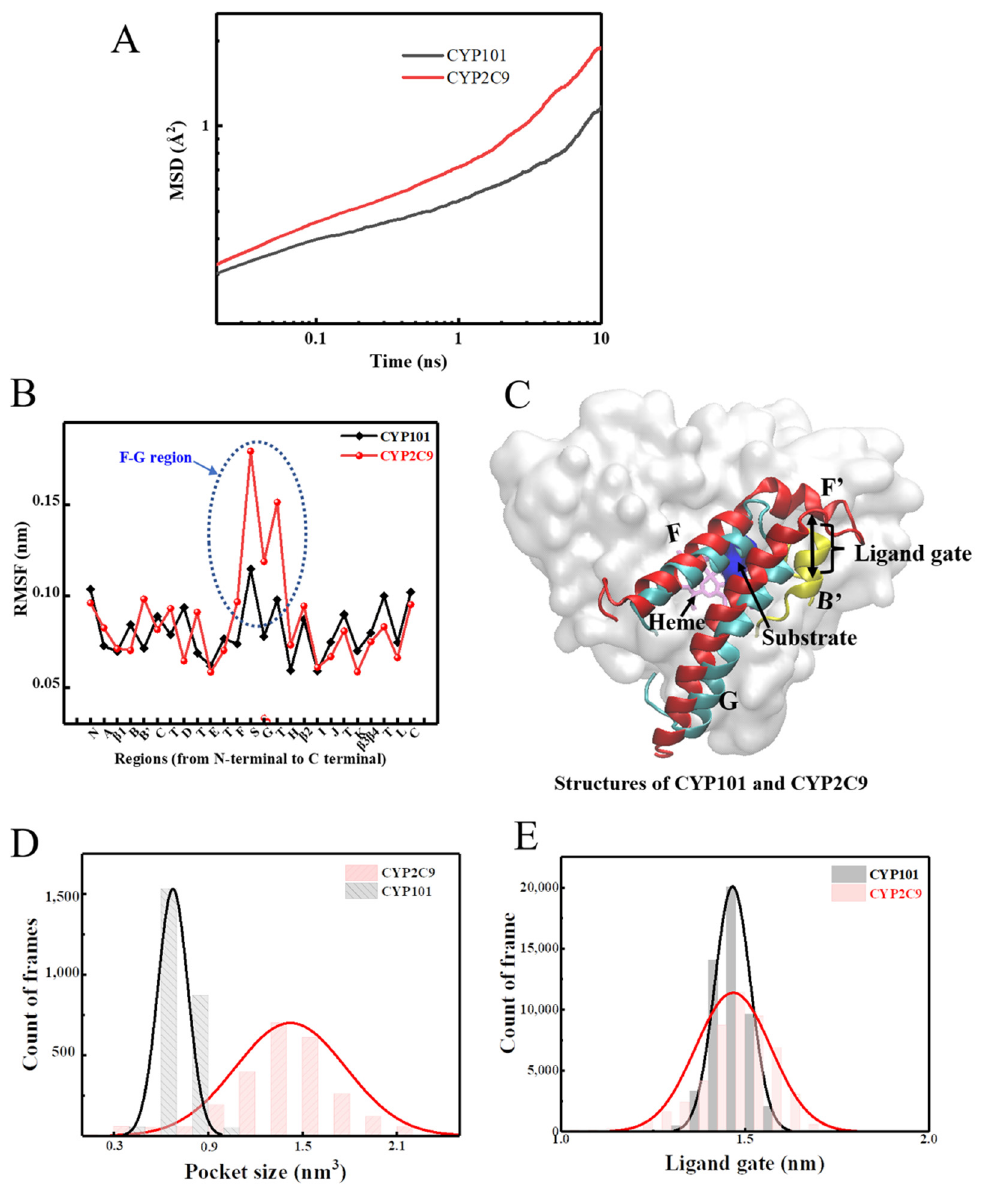
Figure 3. MD-derived flexibilities in CYP101 and CYP2C9 obtained by analyzing three independent 500 ns simulations for each protein. ( A ) Global flexibilities indicated by mean-squared atomic displacement (MSD) (10 ps to 10 ns). ( B ) Local flexibilities suggested by root-mean-square fluctuation (RMSF) clustered on the secondary structures, where the blue dotted circle highlights the most evident difference, appearing at the F–G region. We note that the symbol “S” marked in red corresponds to a linker connecting F and G helices. This linker is composed by coils and F’ helix in CYP2C9 but only a short coil in CYP101 (see Figure 3C). ( C ) Superposition of the crystal structures of CYP101 (cyan, PDB 1DZ9) and CYP2C9 (red, PDB 5XXI) with the F–G region and B’ helix (yellow) highlighted. The ligand gate controlling the opening and closing of the ligand access channel is formed by the B’ helix and the linker connecting F and G helices, and it is marked by a black double-ended arrow. The positions of heme (purple) and the substrate (blue) are also marked out. The distribution of the fluctuations of ( D ) the volume of the catalytic pocket and ( E ) the distance of the ligand gate observed in MD.